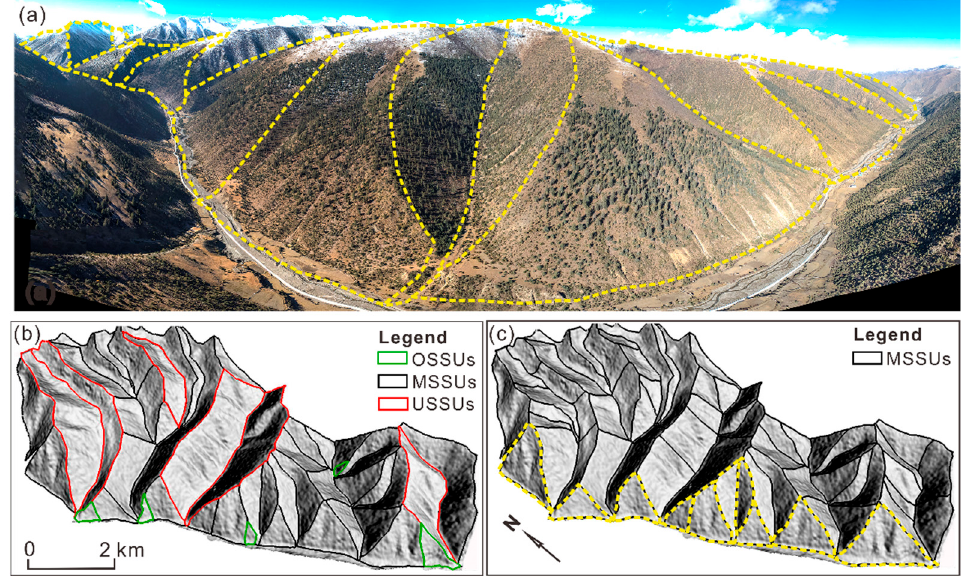
Figure 11. Comparison between the original SUs at single optimal scale and the refined SUs after multi-scale recombination. ( a ) is the field photo for verification, ( b ) are the original SUs before improvement. ( c ) are the final refined SUs achieved by the proposed optimization method, and the yellow dashed line marks the corresponding SUs in ( a ).